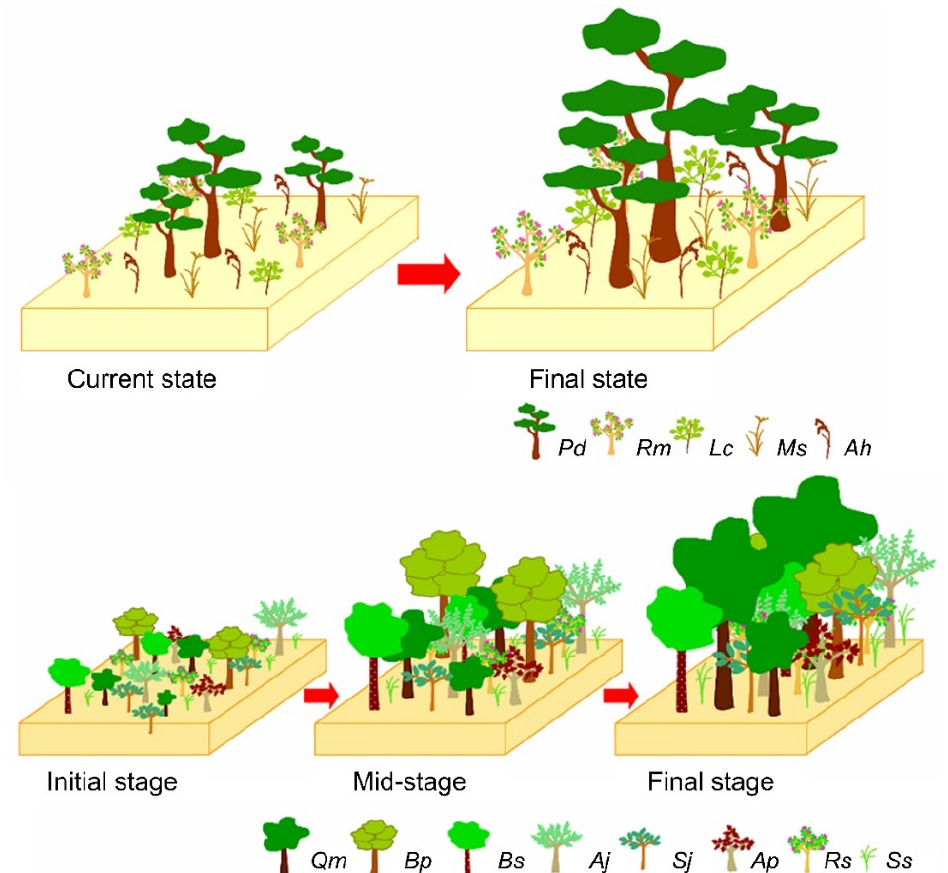
Figure 3. Restoration design prepared to realize true restoration in lowland (upper) and upland (lower) areas, by hypothesizing Pinus densiflora forest (upper) Quercus mongolica forest (lower) in the future. Pd: Pinus densiflora , Rm: Rhododendron mucronulatum Turcz., Lc: Lespedeza cyrtobotrya , Ms: Miscanthus sinensis , Ah: Arundinella hirta , Qm: Quercus mongolica , Bp: Betula platyphylla var. japonica , Bs: Betula schmidtii , Aj: Albizzia julibrissin , Sj: Styrax japonicus , Ap: Acer pseudosieboldianum , Rs: Rhododendron schlippenbachii , Ss: Spodiopogon sibiricus .